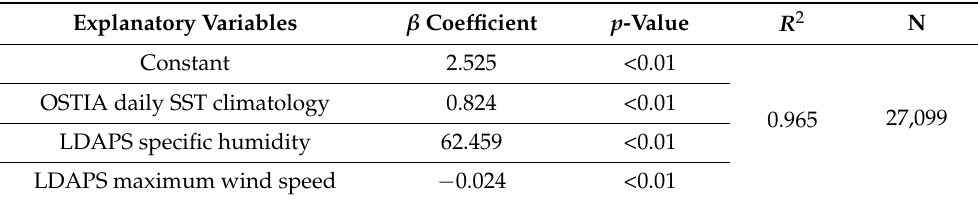
Table 5. Summary of the MLR model for the pixels where GK2A SST and the in situ SST measurements existed in 2020.